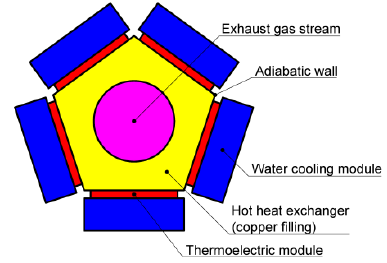
Fig. 1. A cross-sectional view of thermoelectric module assembly